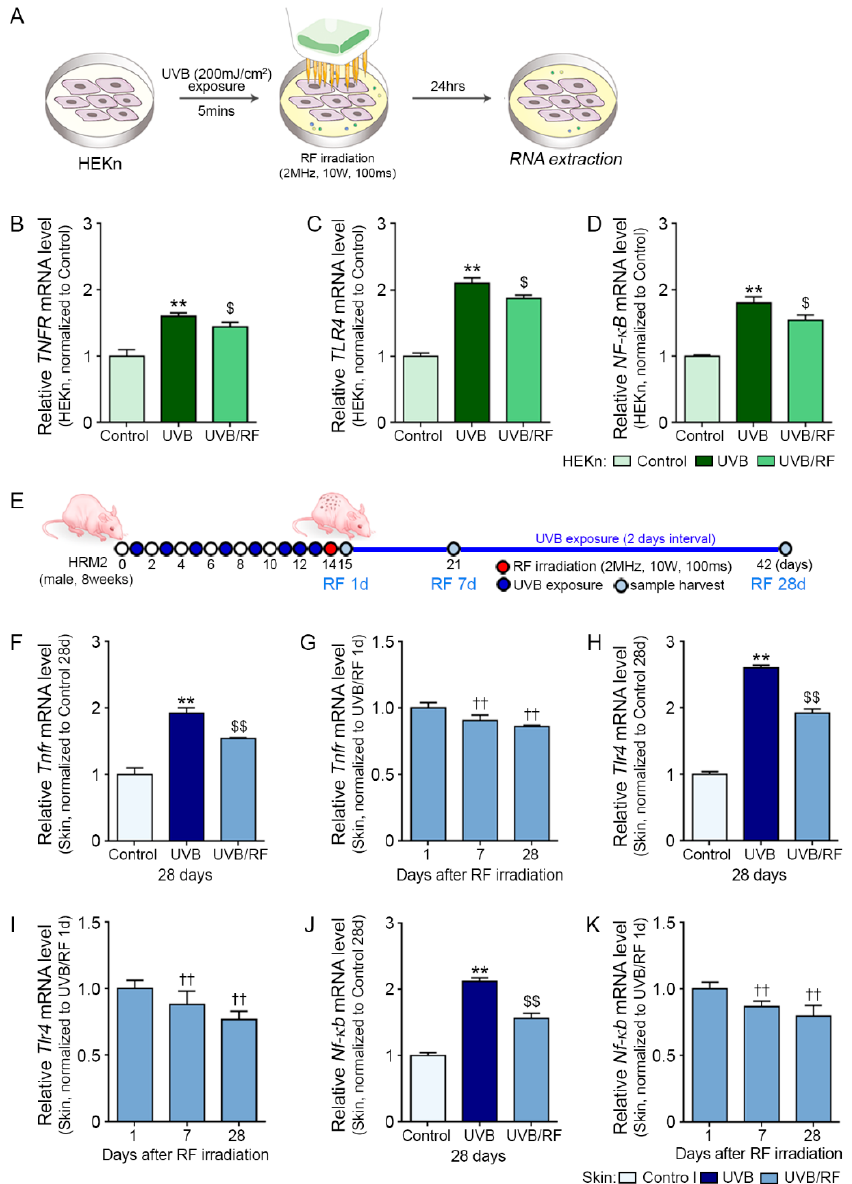
Figure 1. Downregulation of the expressions of TNFR, TLR4 and NF- κ B by RF irradiation. ( A ) HEKn were irradiated either with UV-B (200 mJ/cm 2 ) or with UV-B/RF (2 MHz, 10 W for 100 ms) in vitro, or otherwise not irradiated (control). The mRNA expression levels of ( B ) TNFR, ( C ) TLR4, and NF- κ B ( D ) were determined in HEKn. The mRNA levels in HEKn were measured by qRT-PCR, normalized versus ACTB, and expressed relative to levels in the control group. ( E ) Mouse skins were irradiated either with UV-B (200 mJ/cm 2 ) or with UV-B/RF (2 MHz, 10 W for 100 ms) in vivo, or otherwise not irradiated (control 28 days). The mRNA expression levels of ( F , G ) TNFR, ( H , I ) TLR4, and ( J , K ) NF- κ b were determined in the skin tissue. The mRNA levels in the mouse skins were validated by qRT-PCR, normalized versus ACTB, and expressed relative to levels in the control 28 days group or 1 day after RF irradiation. Data are presented as mean ± SD. **, p < 0.01, vs. control (HEKn) or control 28 days (Skin); $, p < 0.05; $$, p < 0.01, vs. UV-B (HEKn) or UV-B 28 days (Skin); ††, p < 0.01, vs. 1 day after RF irradiation (Mann–Whitney U test). HEKn, human epidermal primary keratinocytes; NF- κ B, nuclear factor kappa-light-chain-enhancer of activated B cells; RF, radiofrequency; TNFR, tumor necrosis factor receptor; TLR4, Toll-like receptor 4; UV-B, ultraviolet-B; UV-B/RF, UV-B plus RF.